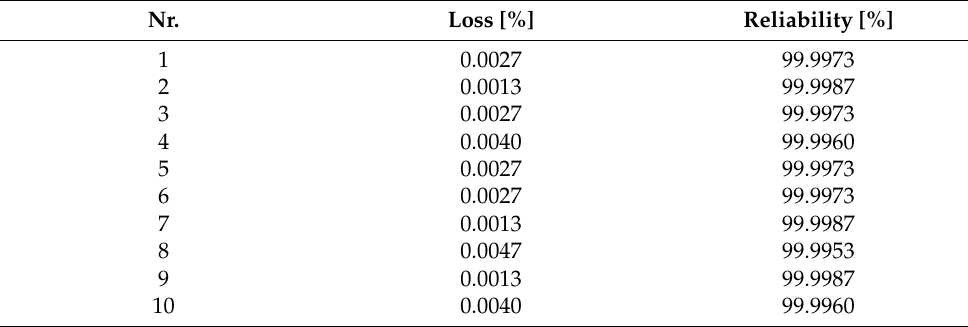
Table 3. Iperf3 results for UDP packages in a 5G-NSA network.